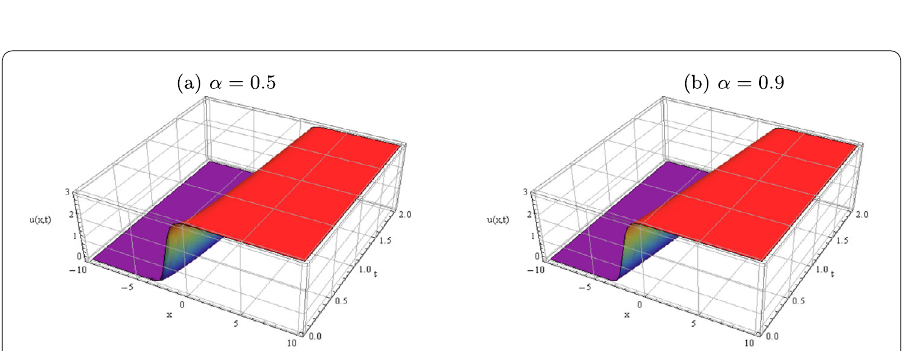
Figure 4 The 3D double-layer solution of equation (6.7) at different values of α = 0.5,0.9 with the suitable parameters k = 0.3, p = 0.2, q = 0.2 which shows that when the value of α decreases the singularity